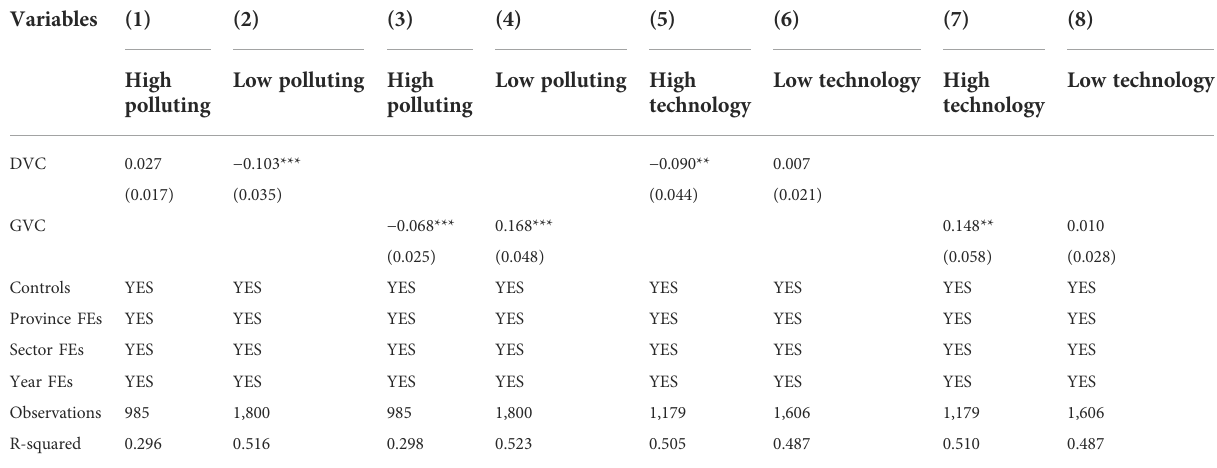
TABLE 6 Heterogeneity regression results a.